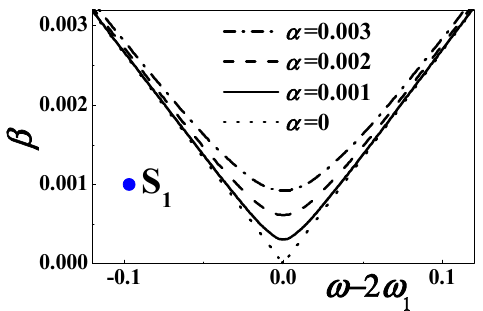
Figure 7. The stability boundary when ω ≈ 2 ω 1.